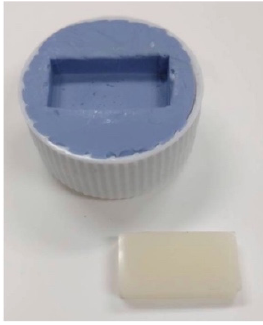
Figure 2. Silicone mold (20 mm (length) × 10 mm (width) × 4 mm (depth)) and resin block.